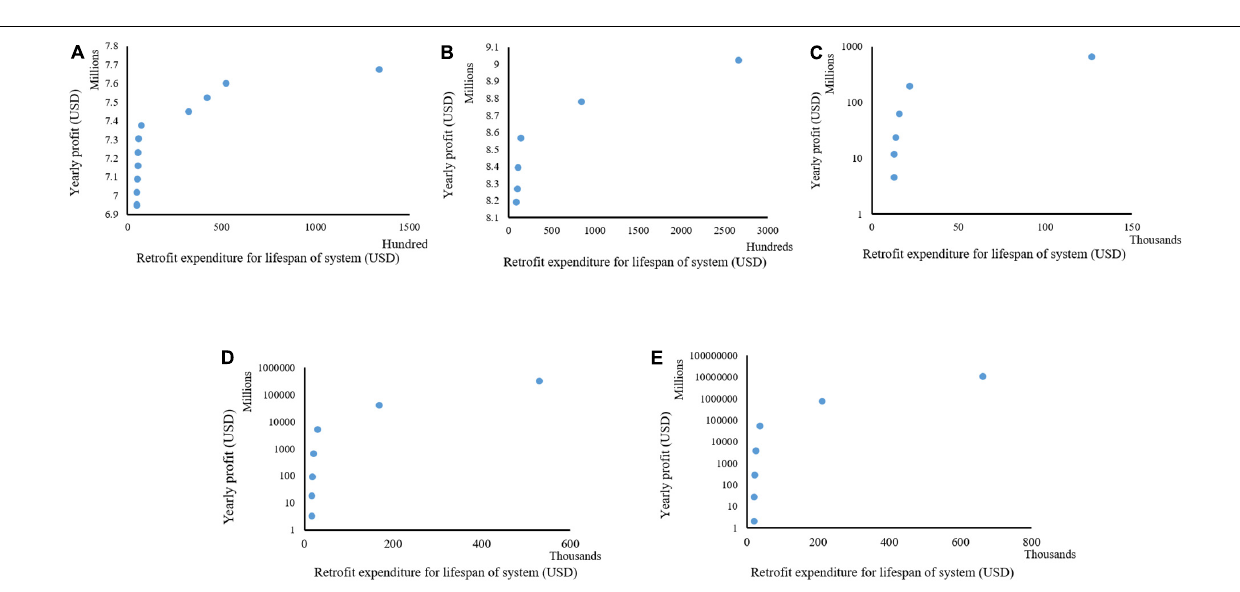
FIGURE 9 | Different combinations of cost of retrofitting and yearly profit derived at different sizes of a plant production system for Case 3; size 1 (A) , size 2 (B) , size 3 (C) , size 4 (D) , and size 5